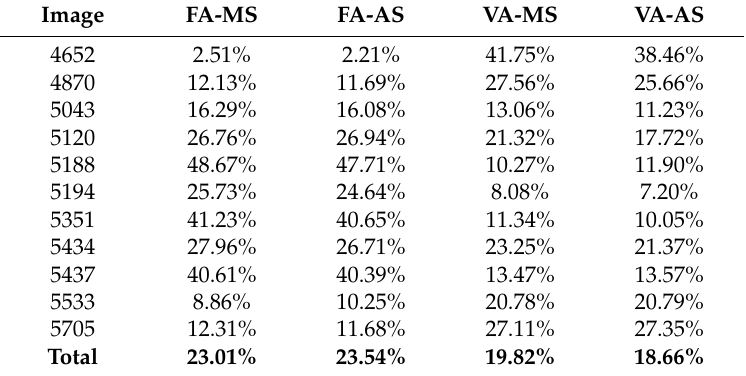
Table 5. Percentage of the whole image area occupied by each RoI (FA—flooded area, VA—vegetation area, MS—manual segmentation, AS—automatic segmentation).